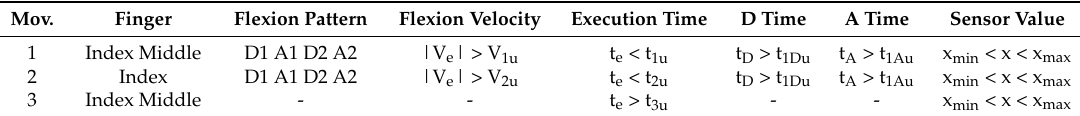
Table 2. Characterization of defined movements.